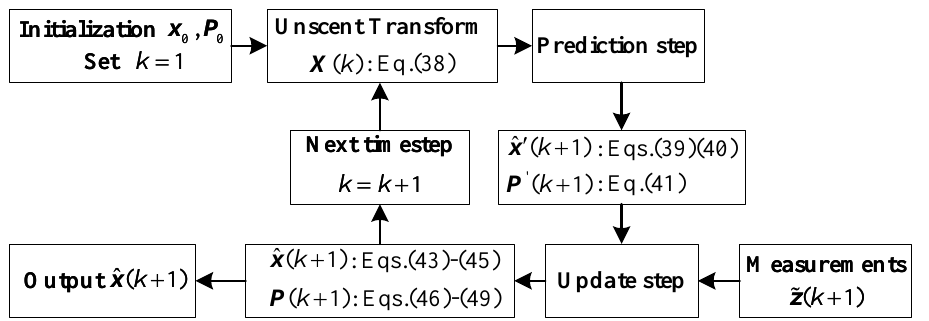
Figure 3. The flowchart of the estimator after the